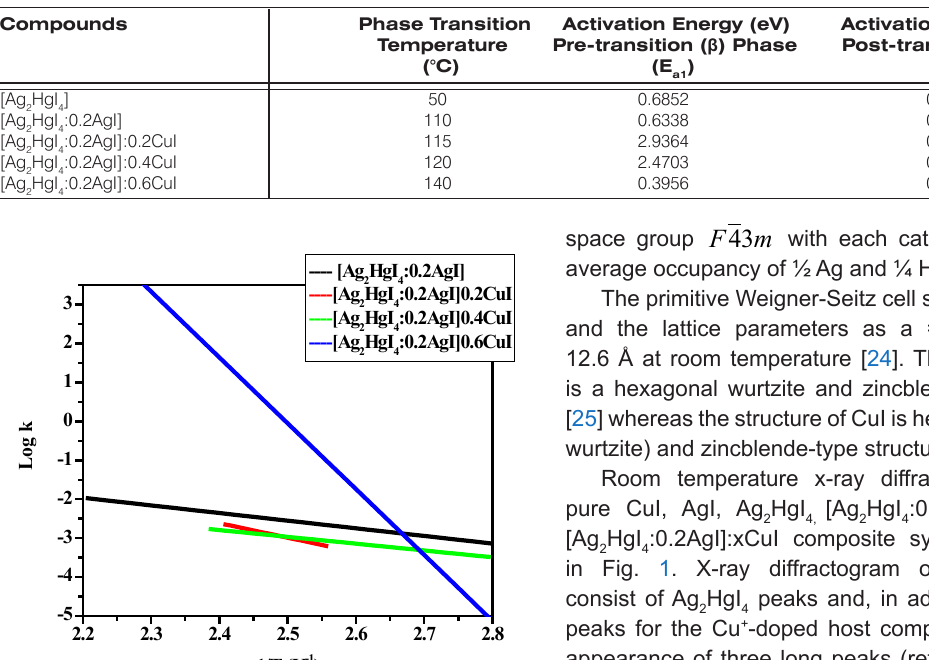
HgI :0.2AgI]:0.xCuI system 2 4